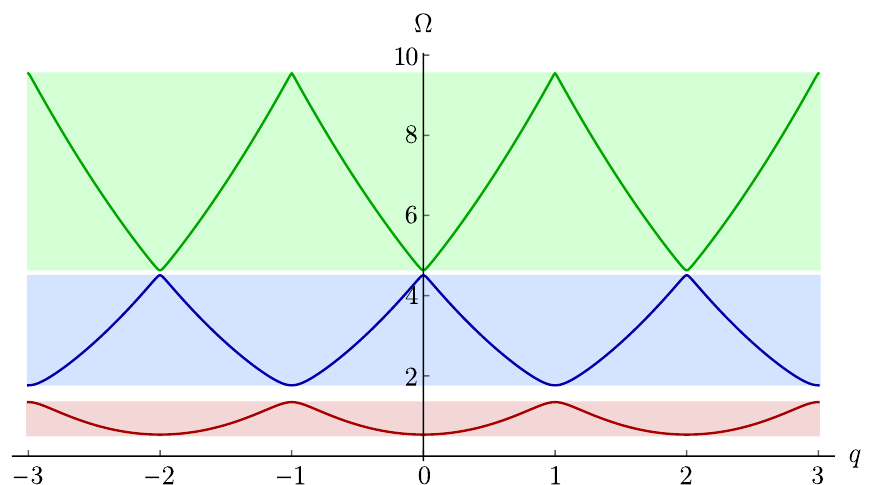
= 1. Three bands are repre- 0 defined in Eq. (B.8). The q